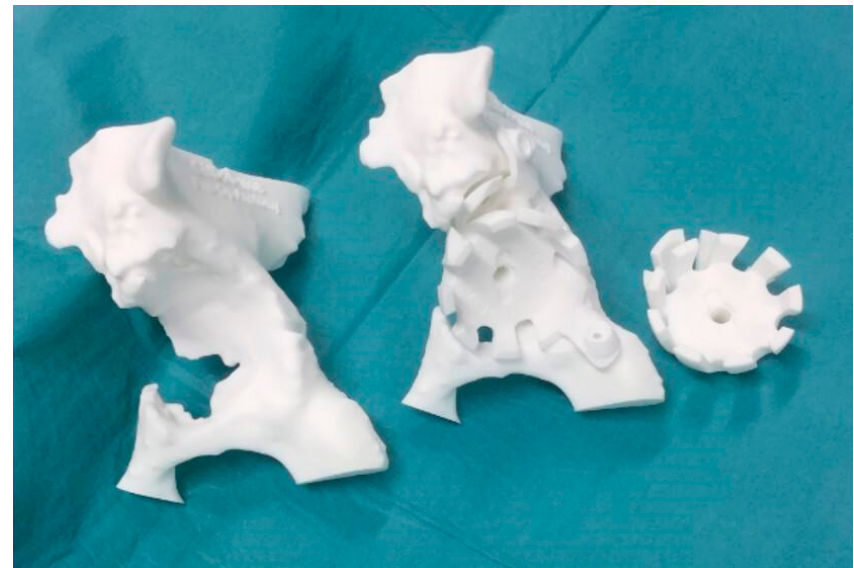
Figure 5. Sterile plastic trials used to check the correct positioning of the custom-made cup during surgery.